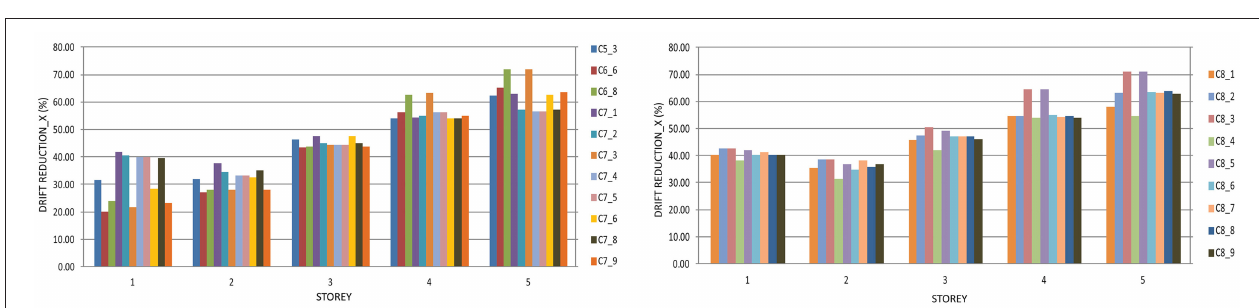
FIGURE 15 | Reduction of inter story drifts in the case of the structure with the optimal solutions from the fifth, sixth, seventh and eighth cycle compared with the structure without dampers in X direction.